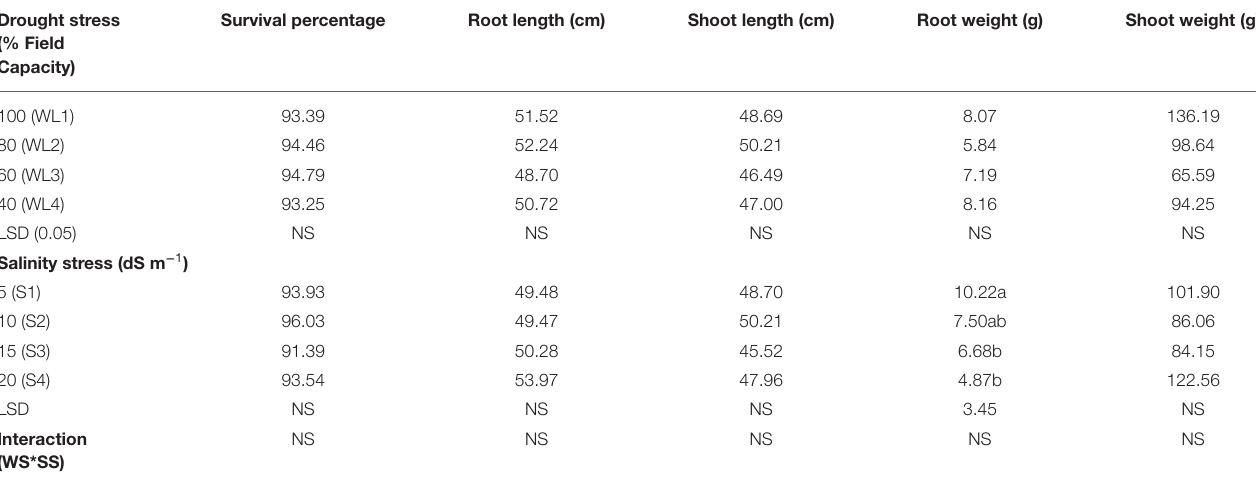
Table 2 | Morphological response of S. imbricata to varying drought and salinity stresses. Drought stress (% Field